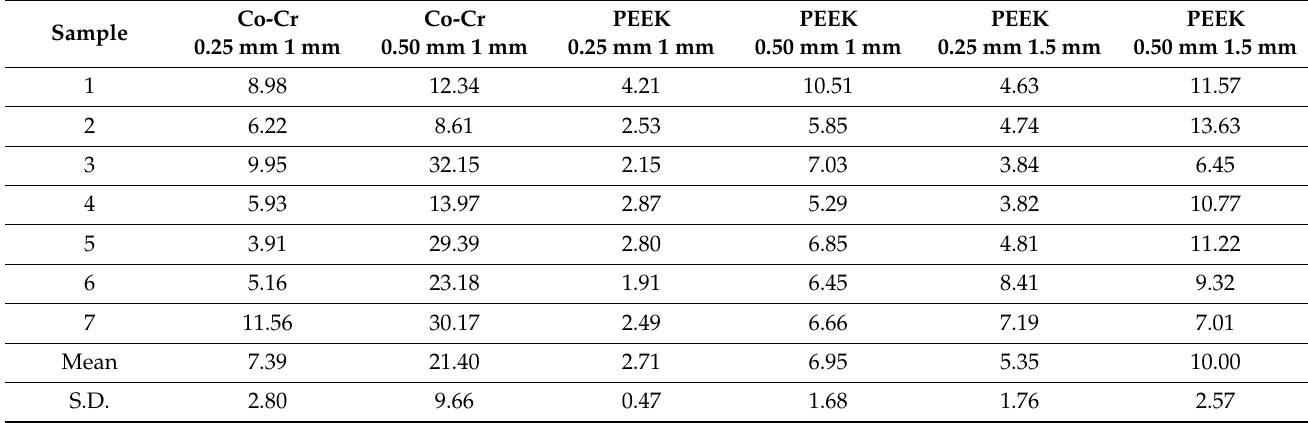
Table 3. The final retentive forces